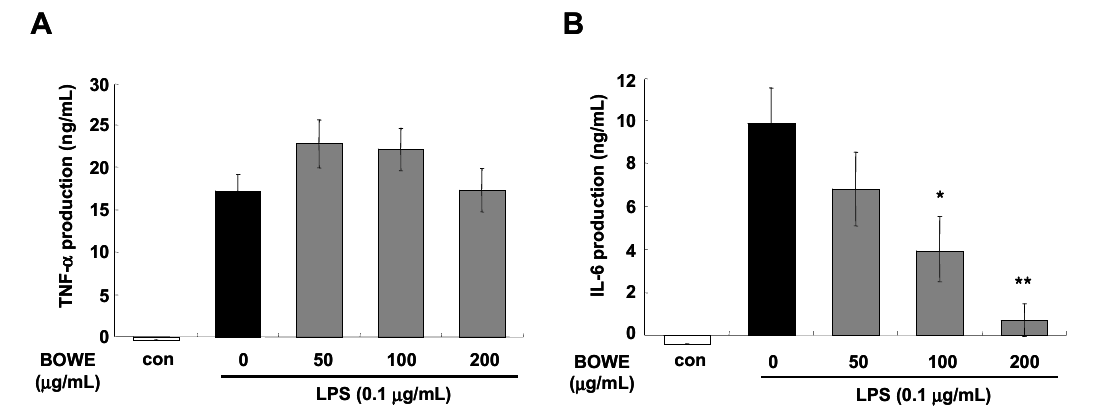
Figure 4. Effect of BOWE on LPS-induced TNF- α ( A ) and IL-6 ( B ) release: BV-2 cells were pretreated with or without the indicated concentrations of BOWE for 4 h and then stimulated with LPS (0.1 μ g/mL) for 18 h. The culture supernatants were subsequently harvested and analyzed for TNF- α and IL-6 levels by ELISA. Data are presented as the means ± SEM in each group (n = 3). * p < 0.05 and ** p < 0.01 denote significant differences compared to the group treated with LPS